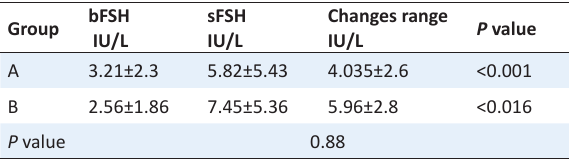
Table 1. The amounts (mean ± SD) of FSH before and after stimulation test and changes range in groups A and B bFSH Group